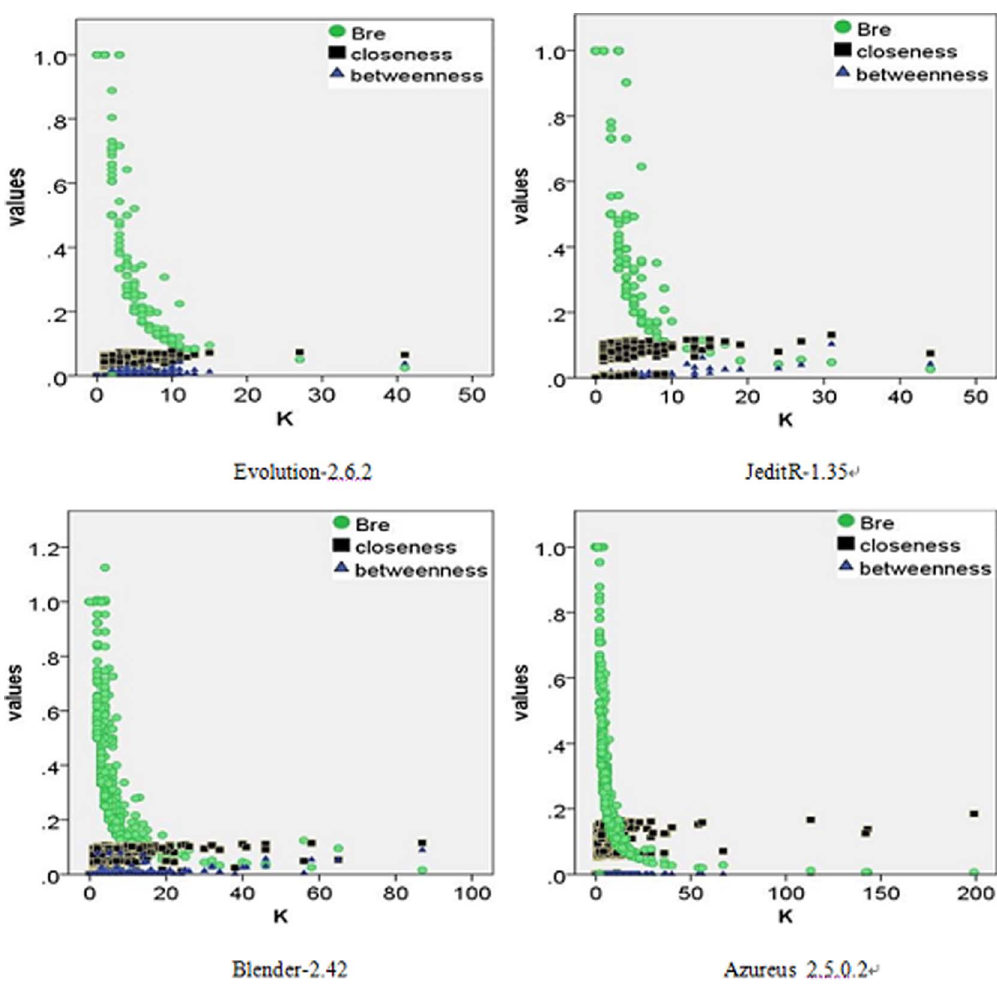
Figure 5. The correlations between the metric model Bre values, closeness, betweenness and the degree K . The corresponding data obtained from Evolution-2.6.2 ( N =1445, M =1129), JeditR-1.35 ( N =822, M =718), Blender-2.42 ( N =2426, M =2848) and Azureus_2.5.0.2 ( N =2375, M =3278), which are well-known software packages. The data points (